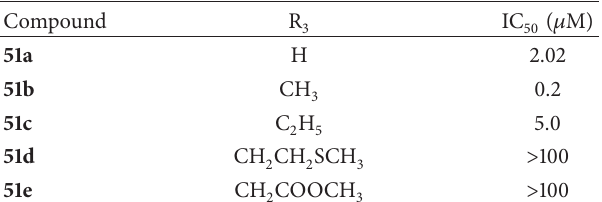
Table 8: List of compounds